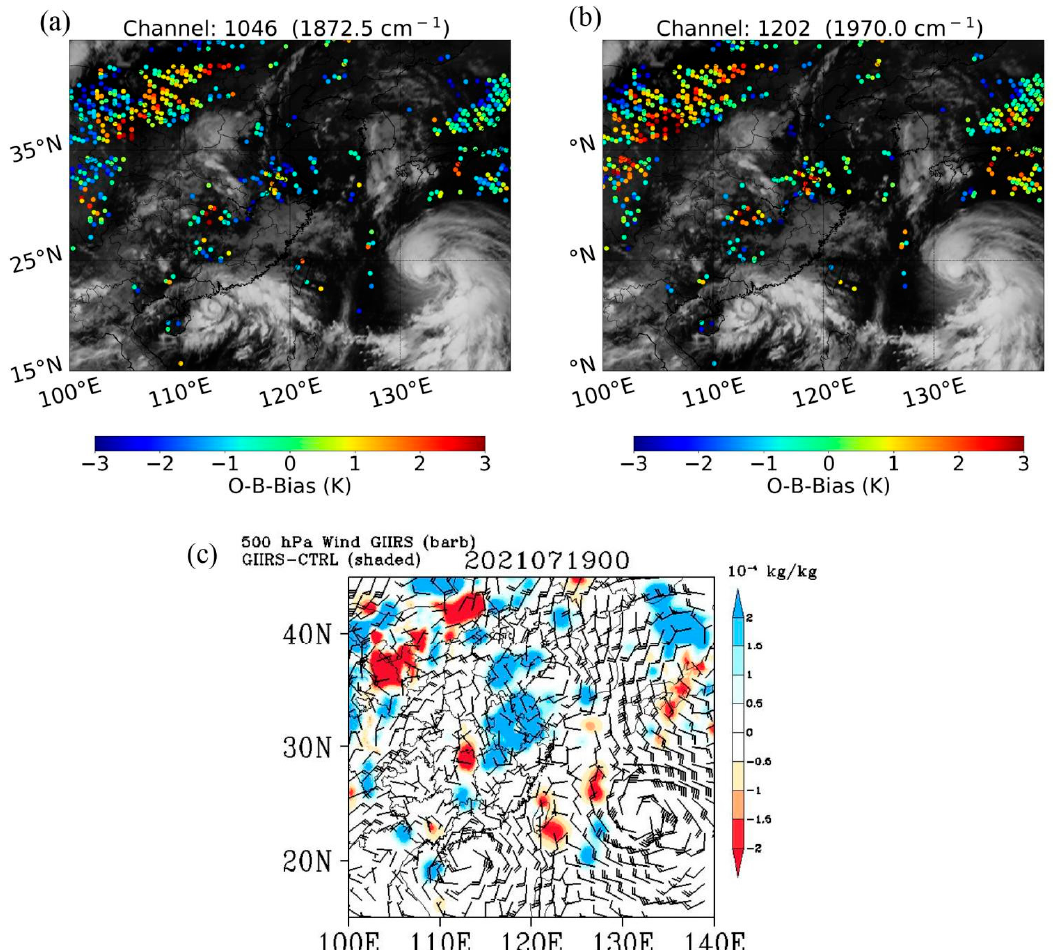
Figure 5. Regional distributions of the differences between observations and simulations (O-B, K) after BC and QC of ( a ) channel 1046 and ( b ) channel 1202. The white ‐ grey ‐ black shadow represents the distribution of clouds that were observed by the AGRI IR window channel (10.8 μ m) at 0000 UTC on 19 July 2021. ( c ) Specific humidity differences (shaded, kg kg − 1 ) between the CTRL and GIIRS experiments (49 WV channels assimilated), and the wind field (black barb) of the GIIRS at 500 hPa. The data used are from the analysis at 0000 UTC on 19 July 2021.